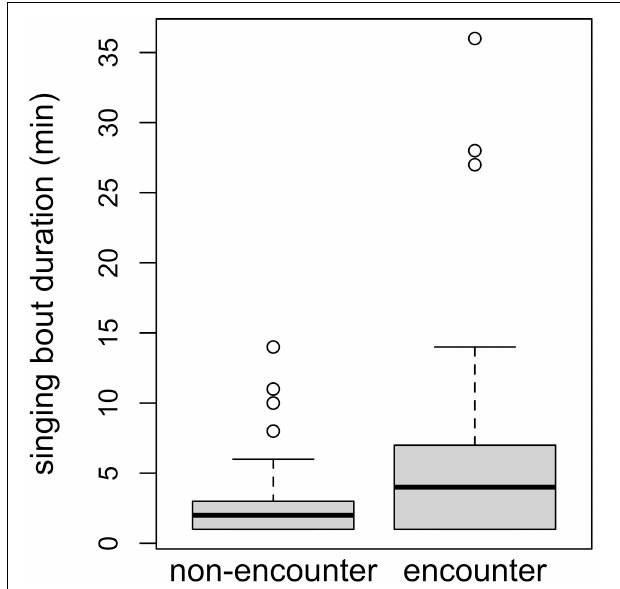
FIGURE 3 | Singing bout durations (in minutes) for encounter and non-encounter contexts. Boxes depict median and lower and upper